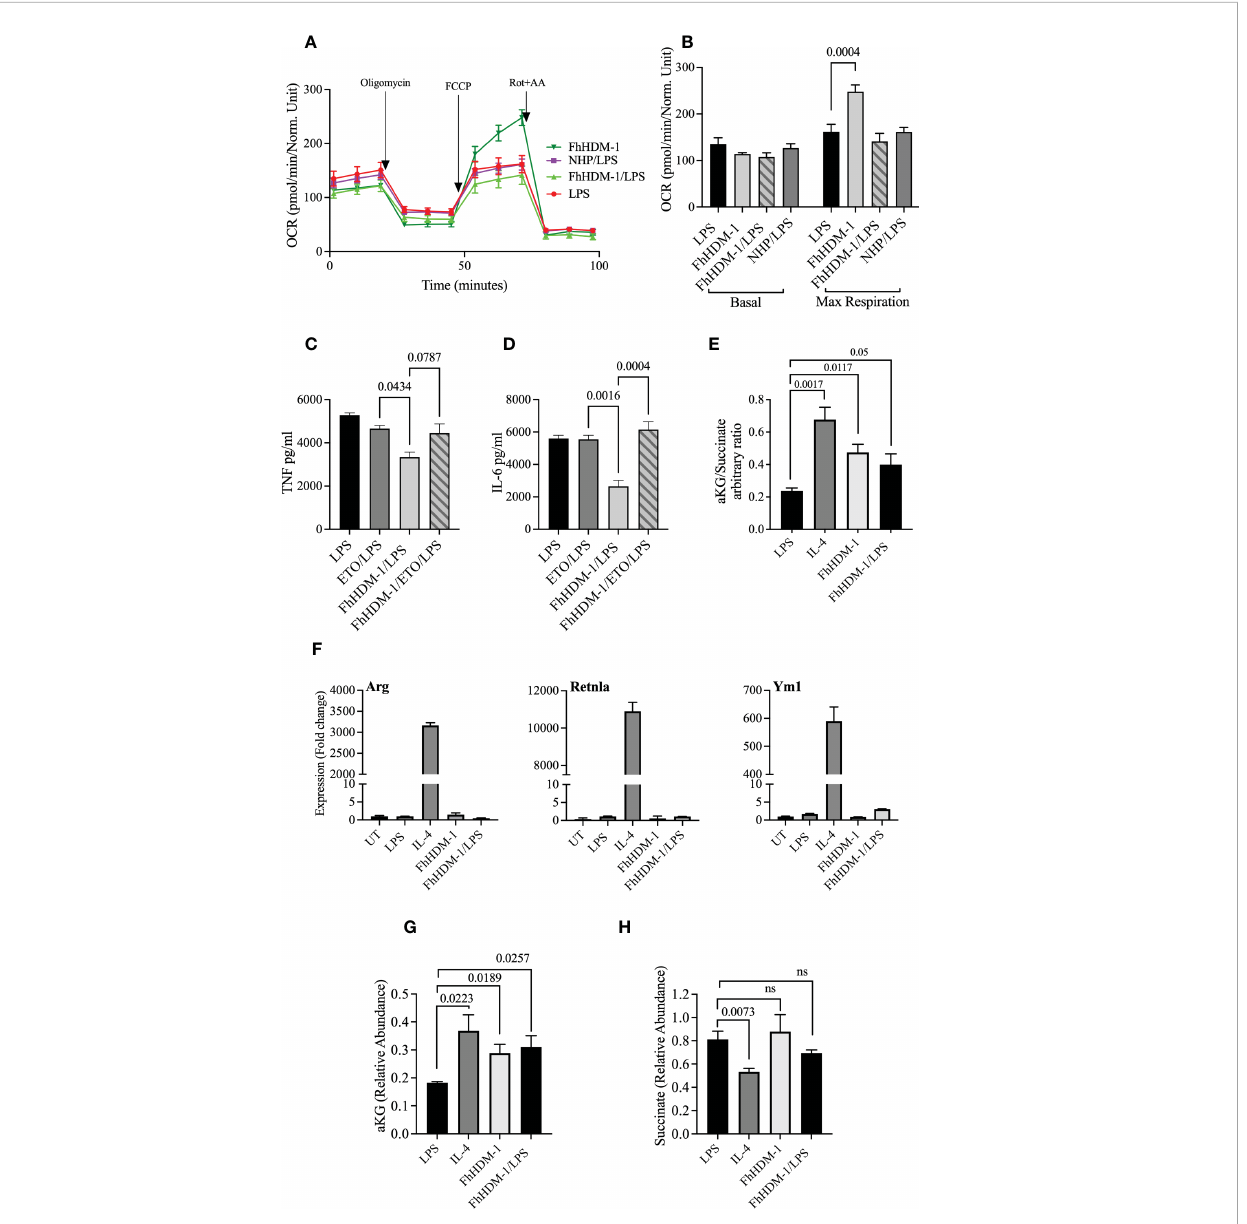
FIGURE 5 The regulation of in fl ammatory response by FhHDM-1 is associated with an increased a Ketoglutarate : Succinate ratio, is dependent on FAS, and is independent of a switch to an M2 phenotype. (A) BMDMs were either untreated (UT) or treated with LPS (20ng/ml), FhHDM-1 (2.5µM), FhHDM/LPS or NHP (2.5µM)/LPS for 18h (n=5). The oxygen consumption rate (OCR) was measured at basal levels and following sequential treatments with oligomycin, FCCP, and rotenone/antimycin A (Rot+AA) to determine (B) the maximum respiratory capacity of cells. (C) BMDMs were treated with LPS (20ng/mL), LPS and Etomoxir (ETO) the inhibitor of fatty acid oxidation (5µM), FhHDM-1 (2.5µM)/LPS or FhHDM-1/ETO/LPS for 18h (n=3). The quantity of TNF, and (D) IL-6 released into the culture media was quanti fi ed by ELISA. (E) The intracellular ratio of a -ketoglutarate( a -KG):succinate in BMDMs treated overnight with LPS (20ng/mL), IL-4 (20ng/mL), FhHDM-1 (15µM), or a combination of FhHDM-1 and LPS (n=6) was calculated from the abundance of the individual metabolites as quanti fi ed by mass spectroscopy. (F) The differential expression of Arg1, Retnl a , and Ym1 was measured by qRT-PCR in cell lysates of BMDMs that were either untreated (UT) or cultured with LPS (20ng/mL), IL-4 (20ng/mL), FhHDM-1 (15µM), or a combination of FhHDM-1 and LPS for 6h (n=3). (G) Intracellular levels of a -KG and (H) succinate in BMDMs treated overnight with LPS (20ng/mL), IL-4 (20ng/mL), FhHDM-1 (15µM) or FhHDM-1 and LPS (n=6) was measured by mass spectrometry after metabolite extraction. Data is representative of three independent experiments and is presented as means ± SEMs. Statistical signi fi cance was determined by a one-way ANOVA with Tukey ’ s multiple comparison test. ns, not signi fi